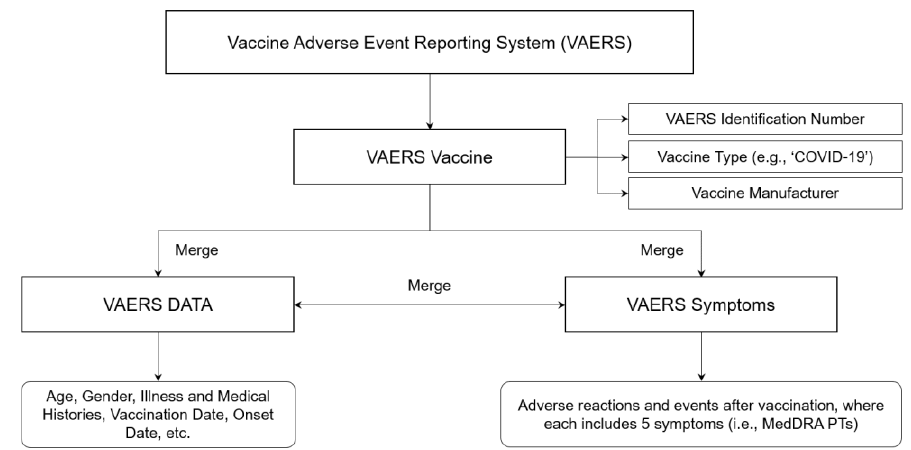
Figure 1. Data collection process.